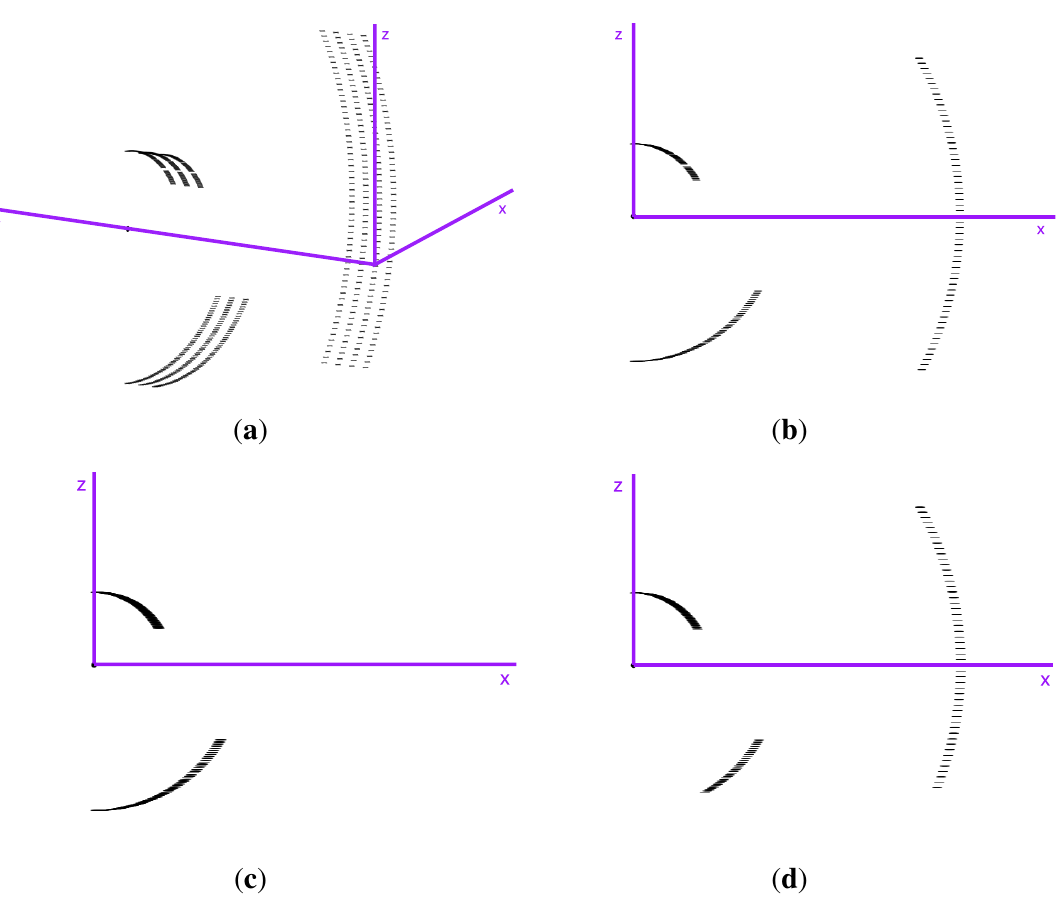
Figure 18. Filters to delete points not intercepted in the tree canopy. (a) Simulated point cloud in axonometric projection; (b) Simulated point cloud in front view; (c) Point cloud after applying distance filter; (d) Point cloud after applying ground